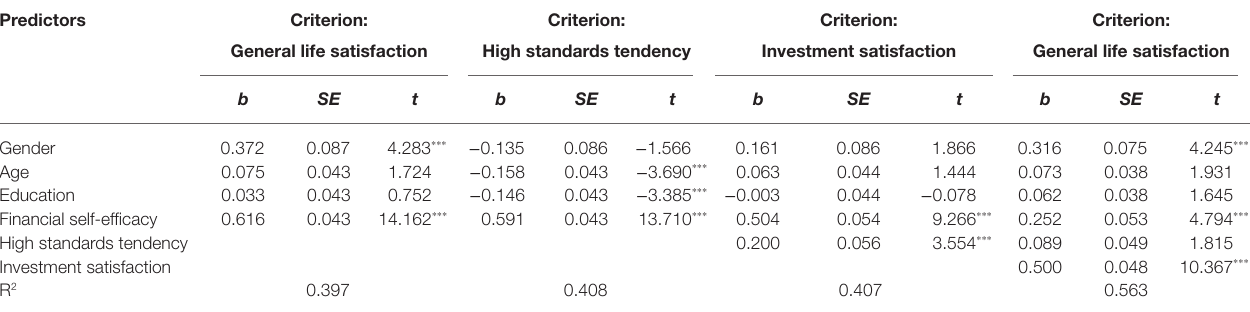
TABLE 2 | Testing the mediation effect of financial self-efficacy on general life satisfaction. Predictors Criterion: General life satisfaction